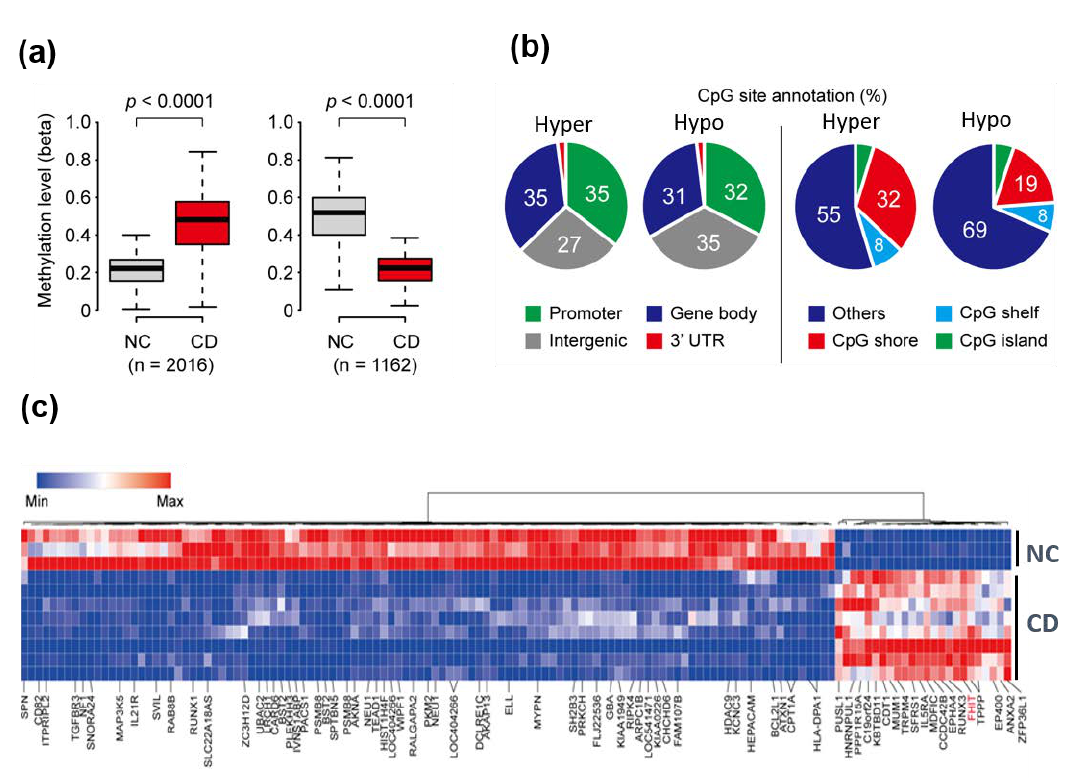
Figure 1. Genome-wide di ff erentially methylated regions in colonoscopy samples from Crohn’s disease patients. ( a ) Genome-wide DNA methylation levels between patients with Crohn’s disease (CD) and normal control tissues were compared using the HumanMethylation450K BeadChip kit. A total of 2016 CpG sites were hypermethylated, while 1162 CpG sites were hypomethylated. p -values were calculated using the Mann–Whitney U test. ( b ) Venn diagram showing the proportion of genome-wide coverage of di ff erentially methylated regions. Promoters, gene bodies, intergenic regions, and gene 3 (cid:48) ends are shown (left panel). The number of methylated DNA loci in islands versus CpG shores (2-kb regions flanking CpG islands) and shelves (2-kb regions flanking shores) (right panel). ( c ) Heat map and hierarchical clustering dendrogram of di ff erential gene methylation profiles between normal colon (NC) tissues and Crohn’s disease (CD)